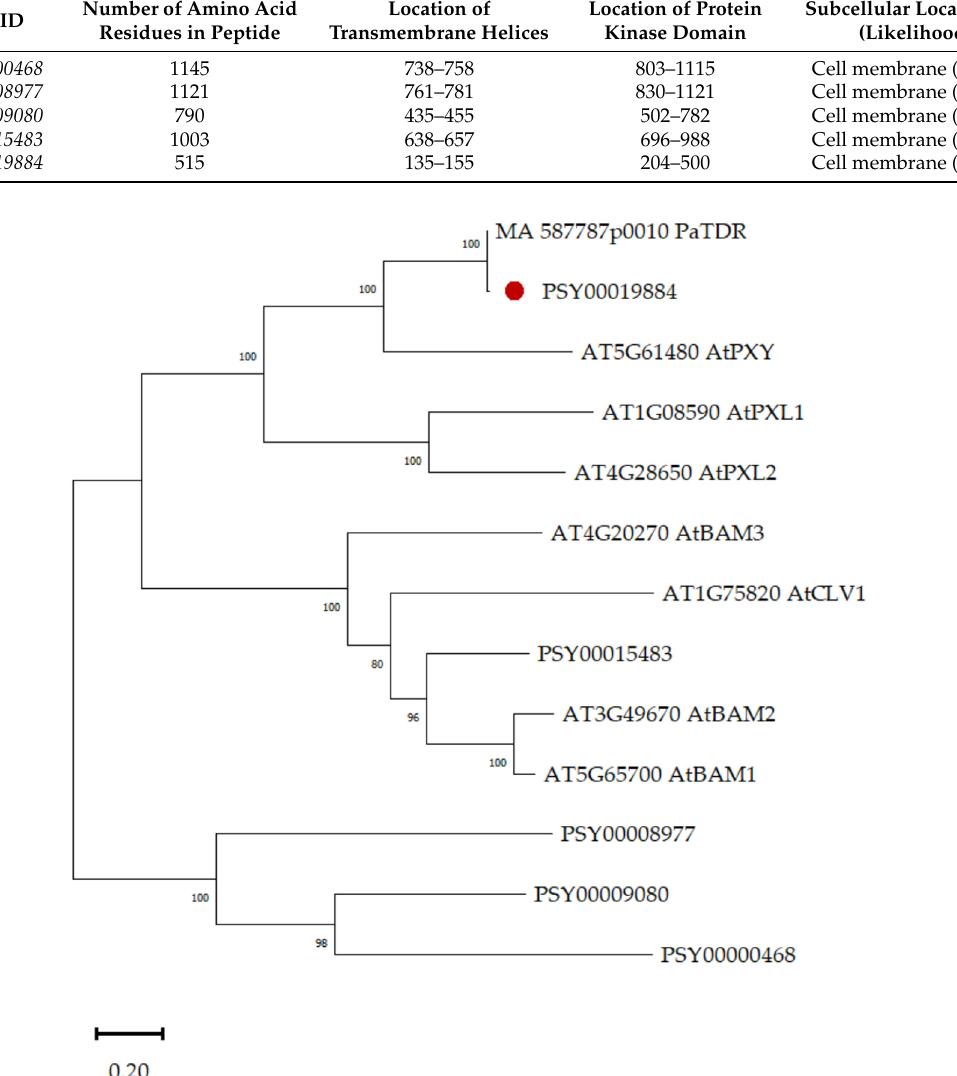
Table 1. Features of the P. sylvestris subgroup XI receptor kinase-like (RLK) family members.